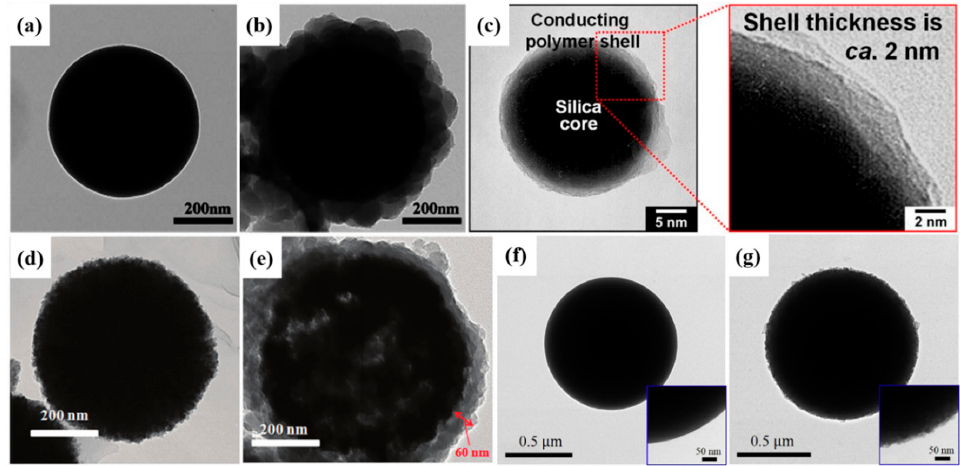
Figure 5. TEM images of ( a , b ) SiO 2 and SiO 2 /PPy synthesized by Kim et al. [95] (© The Royal Society of Chemistry, 2016); ( c ) SiO 2 /PPy synthesized by Hong et al. [96] (© The Royal Society of Chemistry, 2010); ( d , e ) Fe 3 O 4 and Fe 3 O 4 /PPy (Park et al. [97], © The Royal Society of Chemistry, 2015); ( f , g ) PS and PS/PDPA (Kim et al. [98], © Elsevier, 2017).